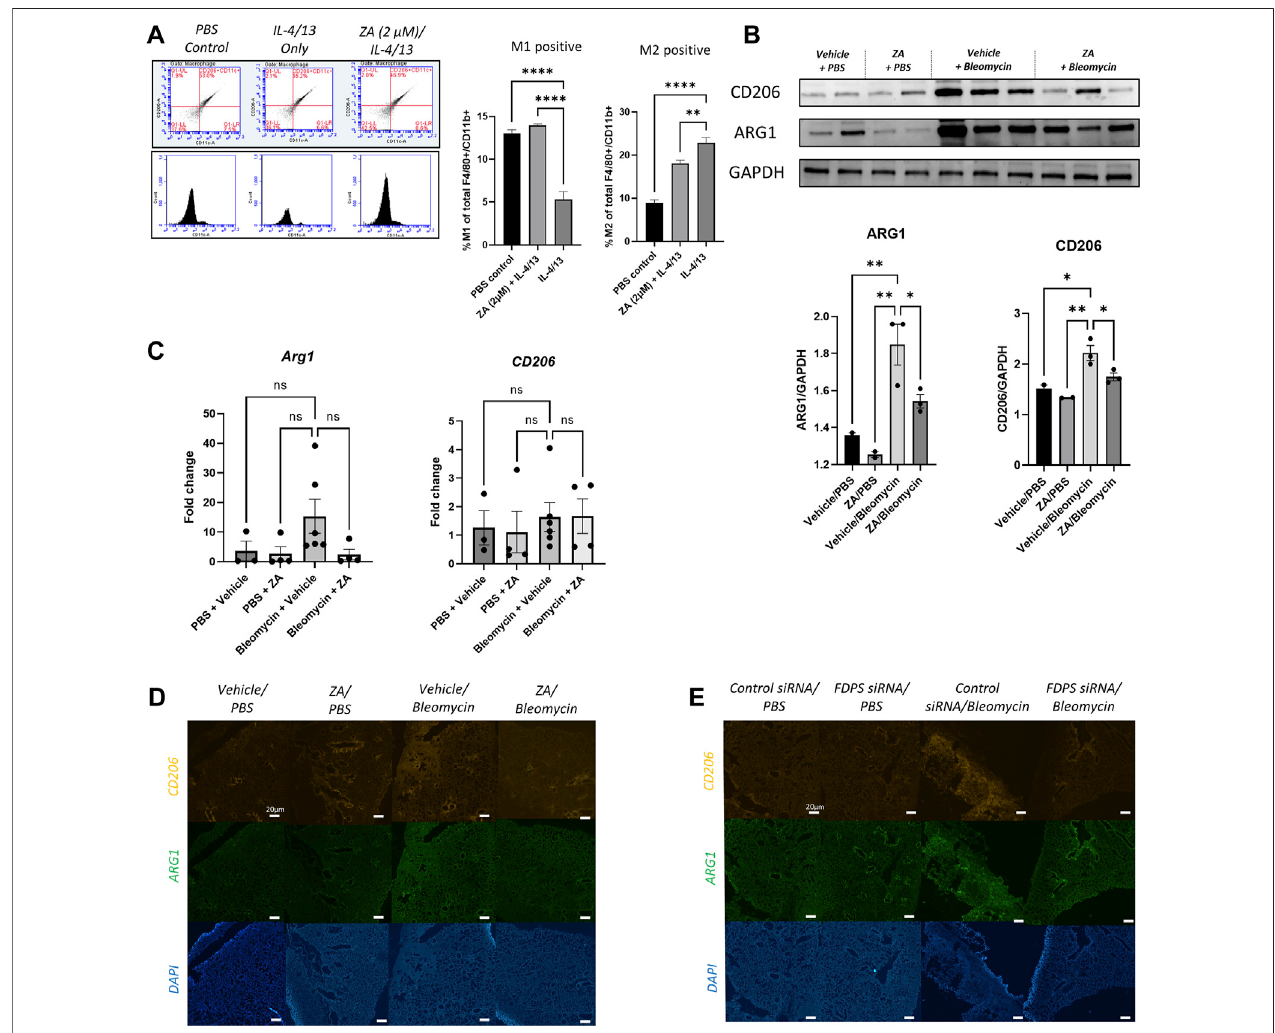
FIGURE 8 | Decreased pro fi brotic macrophage markers following ZA or FDPS siRNA treatment (A) Ex-vivo macrophages were analyzed for M1/M2 using fl ow cytometry, withthe gating strategy shown. Stimulation withIL-4/13 for48 h shifted the macrophages from M1 toM2, whichwasinpart blockedafter ZA administration. M1 positive (CD206 - /CD11c + /F4/80 + /CD11b + ) and M2 positive (CD206 + /CD11c − /F4/80 + /CD11b + ) macrophages graphed as percentages. Statistical comparison between groups were performed using a one-way ANOVA with Dunnett ’ s post-hoc test (* p < 0.05; ** p < 0.01; *** p < 0.001). (B) SDS-PAGE followed by western blotwithantibodiesforarginase1(ARG1)andclusterofdifferentiation206(CD206).Intensityquanti fi cation, normalizedtoGlyceraldehyde 3-phosphatedehydrogenase (GAPDH), of the bands showed decreased protein levels of ARG1 and CD206 after treatment with ZA. Statistical comparison between groups were performed using a one-way ANOVA with Dunnett ’ s post-hoc test (* p < 0.05; ** p < 0.01; *** p < 0.001). (C) Real-time quantitative PCR (RT-qPCR) analysis of Arg1 and CD206 in lung after bleomycin exposure and treatment with ZA. The mRNA expression was normalized against succinate dehydrogenase complex subunit A ( Sdha ) and fold change was calculated by difference between all treatment groups compared to PBS/vehicle. Statistical differences between groups were calculated using a one-way ANOVA with Dunnett ’ spost-hoctest (D,E) Immuno fl uorescencestainingofARG1andCD206inlungsectionsrevealedanincreasedsignalintensityafterbleomycinexposure,which was reduced with administration of ZA (D) or FDPS siRNA (E) .